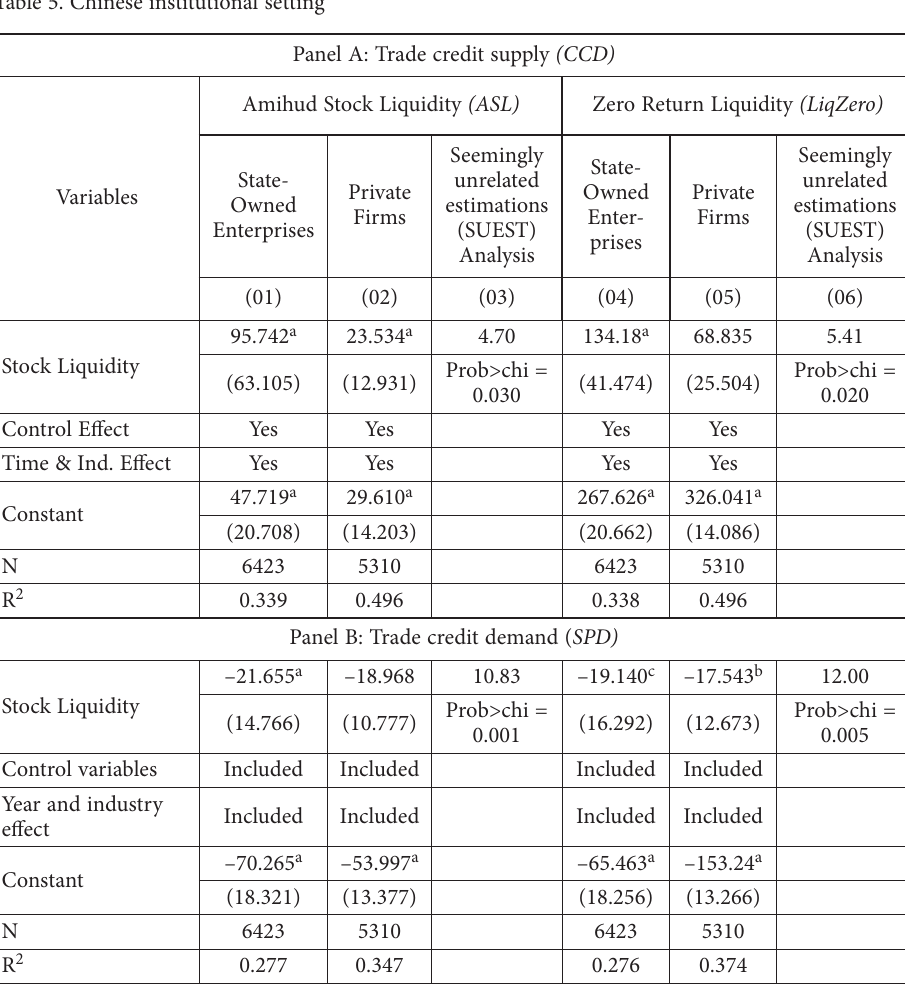
Table 5. Chinese institutional